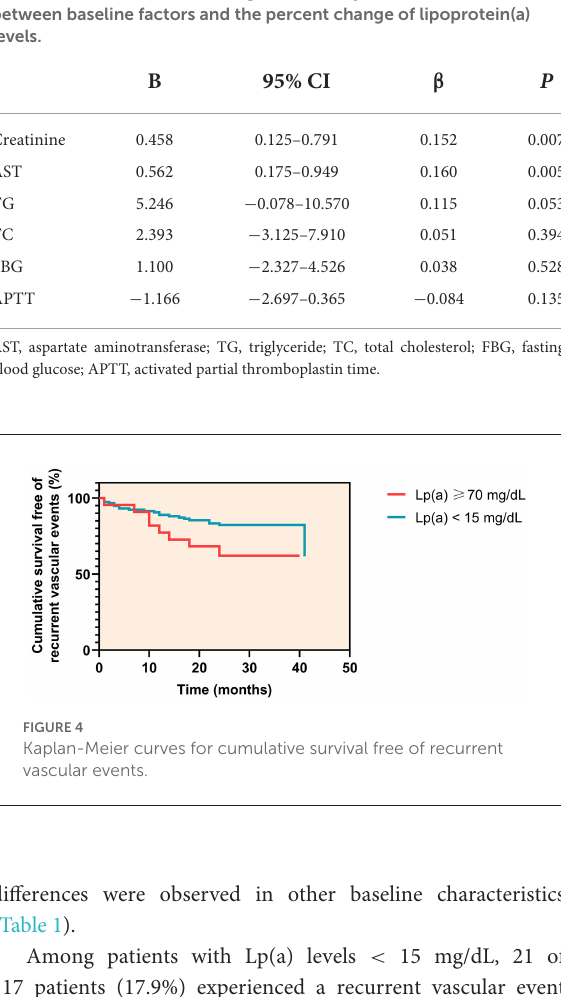
TABLE 2 Univariate linear regression analysis on the association between baseline factors and the percent change of lipoprotein(a) levels.